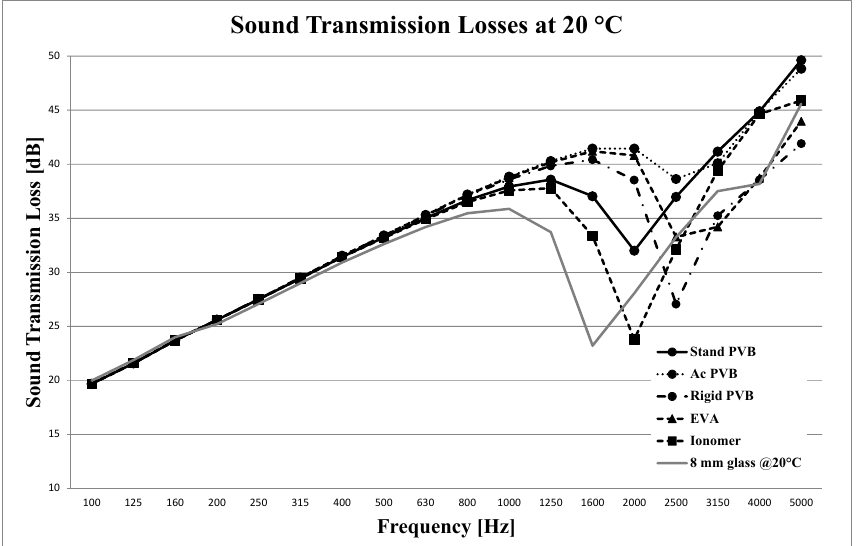
Fig. 12 Sound Transmission Loss Curves of laminated glass at